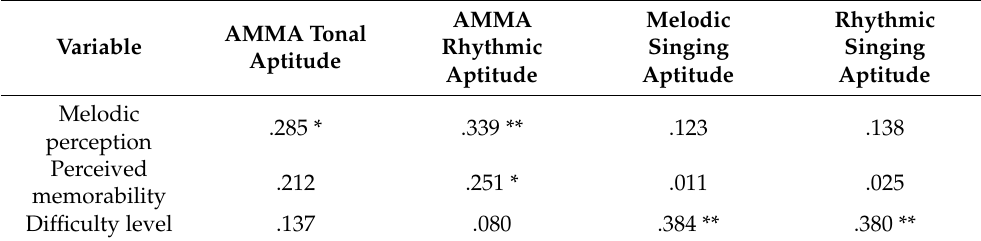
Table 5. The correlational analysis of the behavioral perceptual language ratings and the selected music variables. Rhythmic Melodic AMMA AMMA Tonal Singing Singing Rhythmic Variable Aptitude Aptitude Aptitude Aptitude Melodic .285 * .339 ** .123 .138 perception Perceived .212 .251 * .011 .025 memorability Difficulty level .137 .080 .384 ** .380